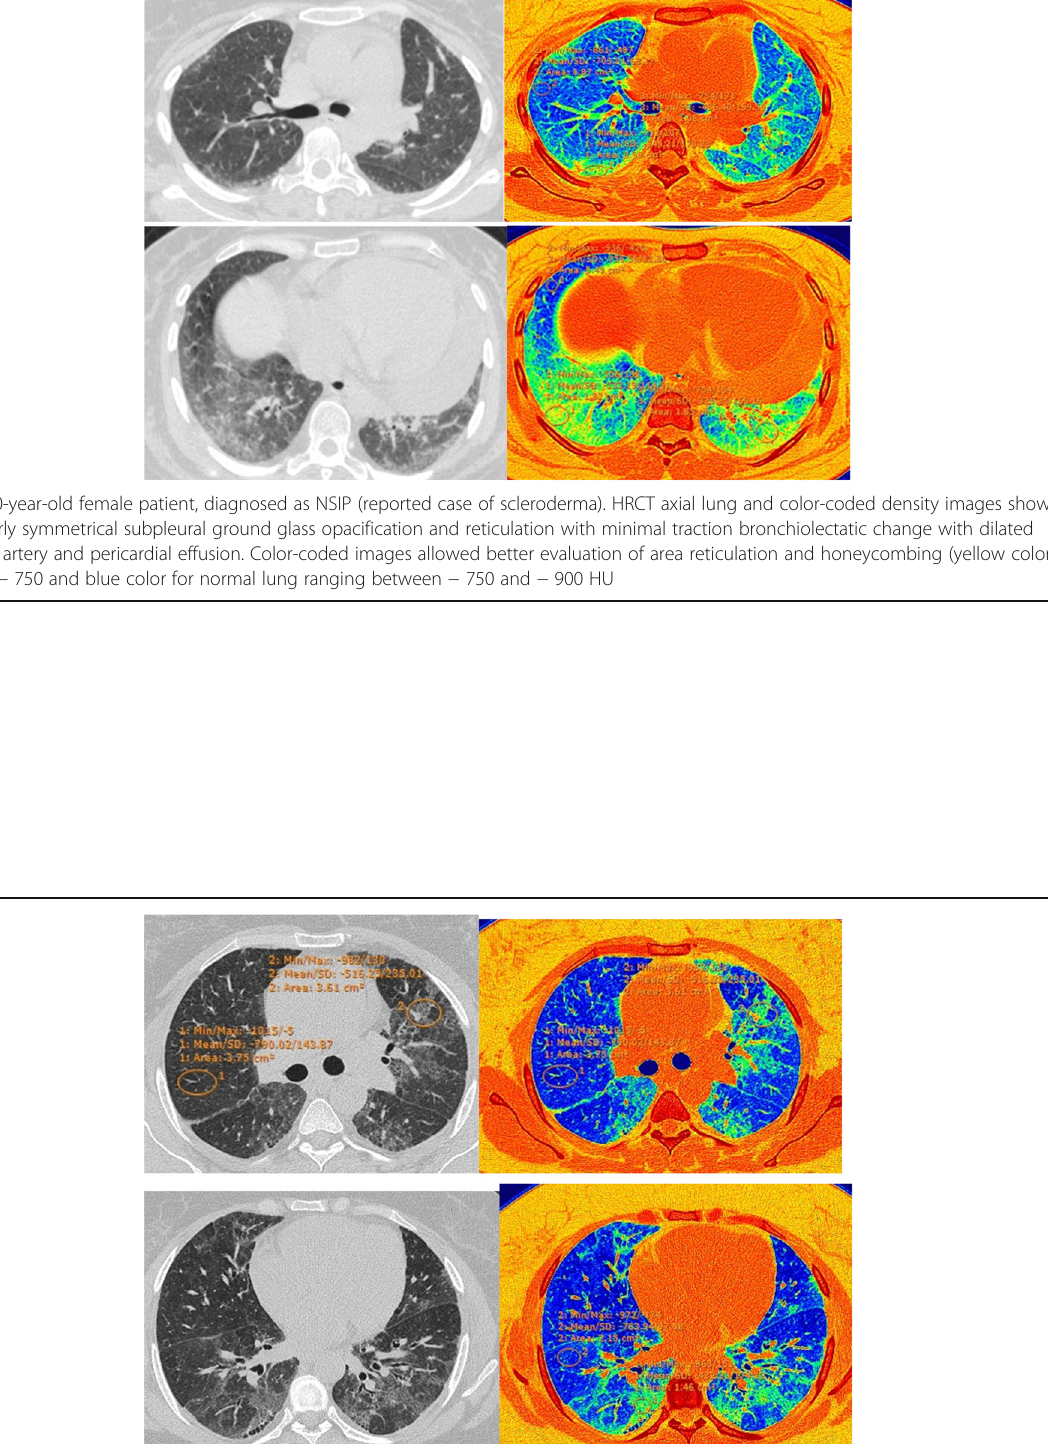
Fig. 6 A 42-year-old female patient with long history of dry cough. Diagnosed as fibrotic type NSIP. HRCT axial lung and color-coded image, showing bilateral subpleural ground glass opacification, reticulation, and minimal microcystic honeycombing. Area of ground glass opacification and reticulation appears green with microcystic honeycombing appearing as small deep blue lucencies within (ranging above − 750 HU), and normal lung appears blue (ranging HU between − 750 and − 900